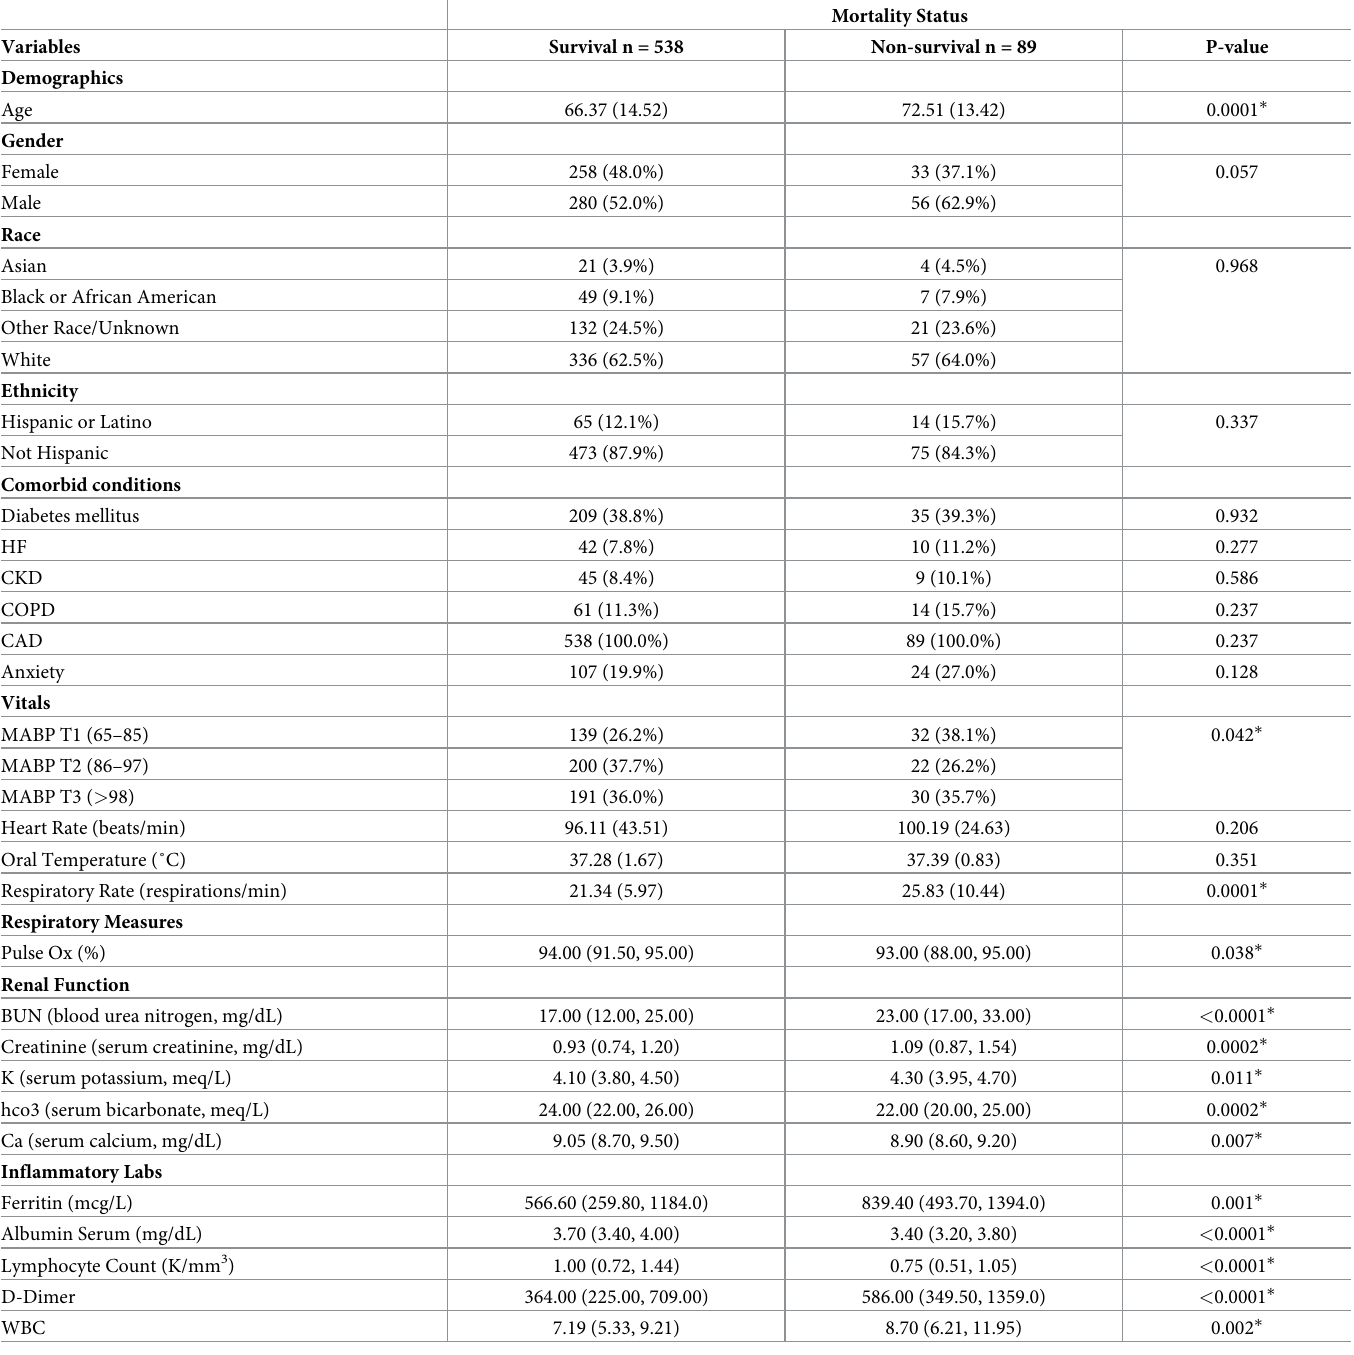
Table 3. Comparison of hypertensive COVID-19 positive patients who expired and